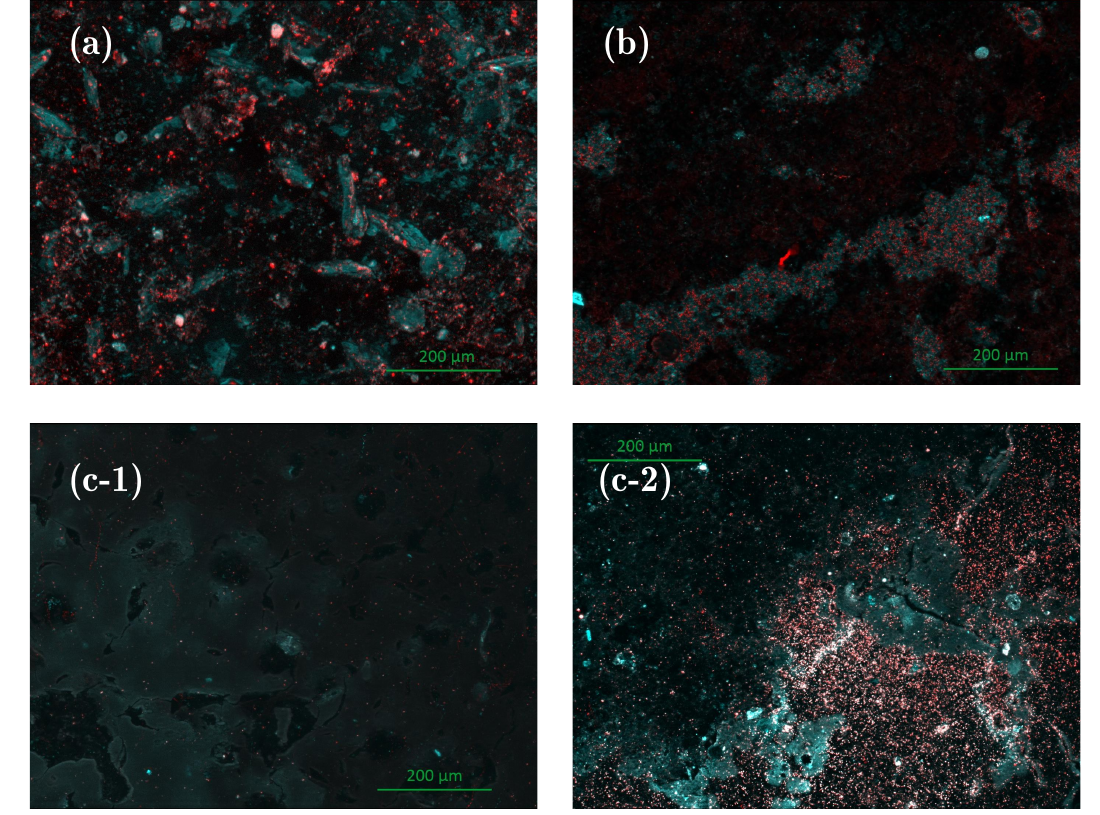
Figure 5. Epifluorescence pictures of surface samples after 24 h of experiment. ( a ) control-coated sample kept in the dark; ( b ) control-coated sample under UV irradiation; ( c ) TiO 2 -coated samples under UV irradiation. For TiO 2 -coated samples, one image was taken at the center of the sample ( c-1 ) and another at the edge ( c-2